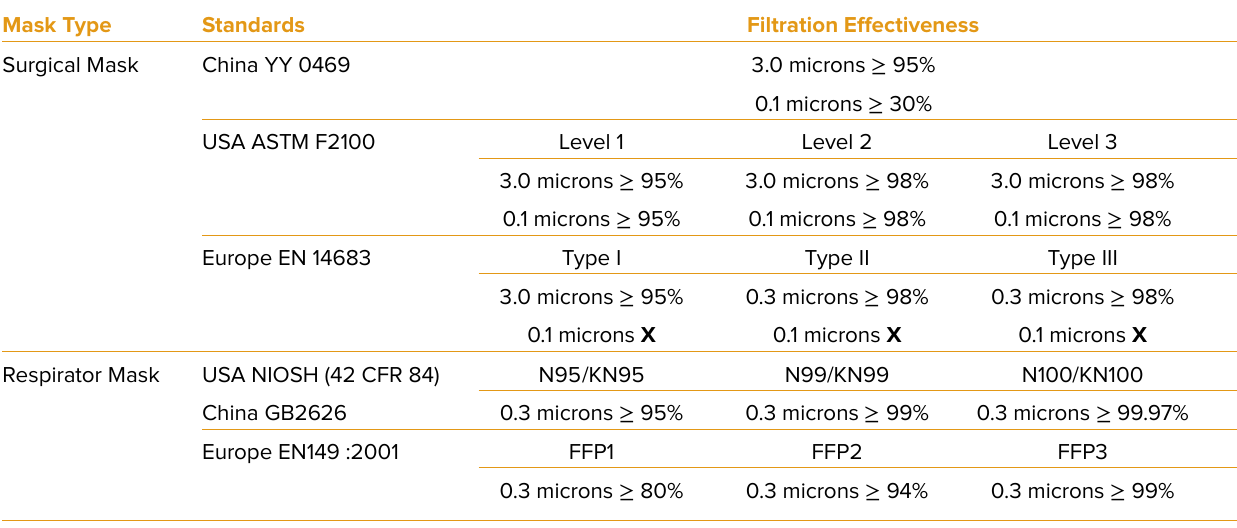
Table 1. Comparison of different commonly used face mask/respirator in the market [21,22]